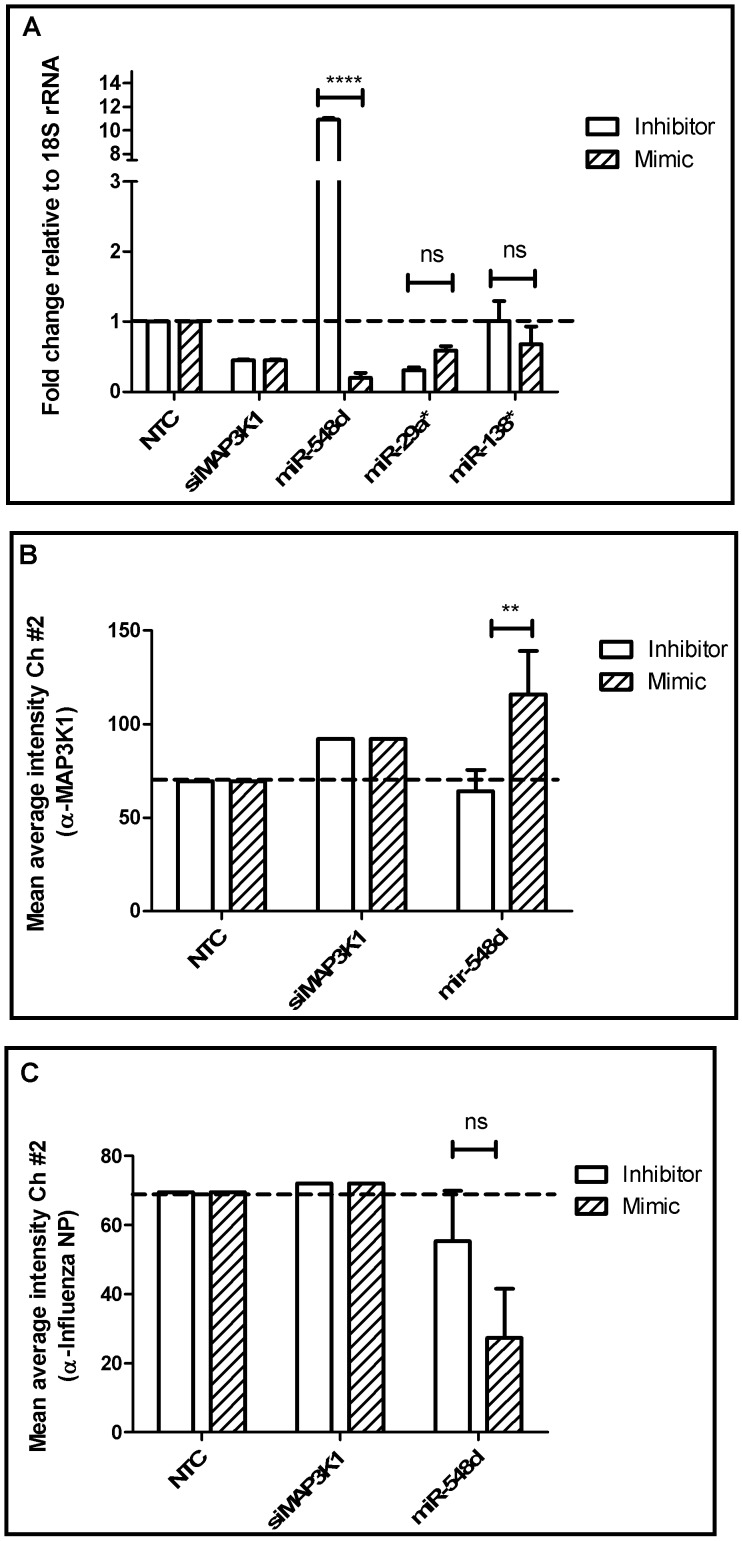
miRNA regulators of MAP3K1.(A) A549 cells were transfected with 25 nM of miR-548d, -29a and -138 inhibitor/mimic for 48 hrs followed by RNA extraction and RT-qPCR with MAP3K1 specific primers. Expression data was normalized to 18S rRNA expression and shown as mean±SEM of independent experiments. *p<0.05 compared to control. (B) A549 cells mock/transfected with miR-548d inhibitor/mimic for 48 hrs were fixed with 4% formaldehyde in PBS and stained for MAPK1 protein using biotinylated rabbit anti-MAP3K1 antibody (Abcam ab69533) and detected with Streptavidin-Alexa488. Cells were analyzed by Arrayscan Cellomics VTI scanner and data analyzed by GraphPad Prism. (C) A549 cells mock/transfected with miR-548d inhibitor/mimic for 48 hrs were infected with A/WSN/33 (MOI = 0.001) for 48 hrs and stained for influenza NP protein using mouse-anti-NP coupled to Alexa-488 and analyzed as above in (B). Data show mean±SEM of two independent experiments. *p<0.05.